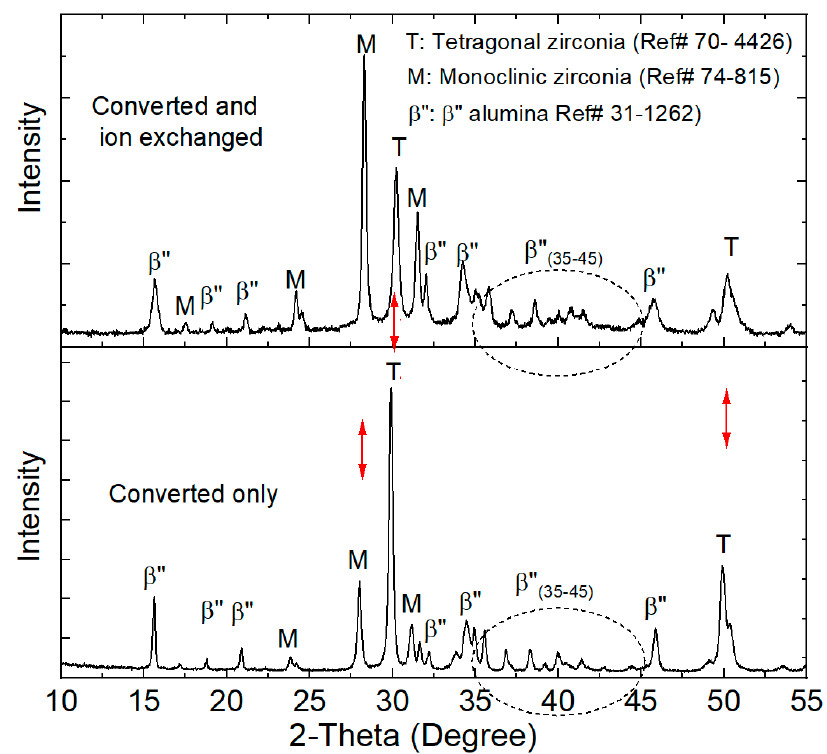
Figure 4. Comparison of samples without (converted only) and with ion exchange for 24 h at 370 °C in LiNO 3 . The characteristic β″ -alumina peaks are labeled (mainly for peaks at 16°, 32°, 46°. and a group of low scattered between 35°–45°). Both tetragonal and monoclinic phases of zirconia can be seen in the figure. Tetragonal to monoclinic phase transformation was observed based on relative intensity change of two zirconia phases. The sample was very strong and exhibited no obvious cracks. Double arrows indicate sign of tetragonal to monoclinic zirconia transformation after extended ion exchange period.